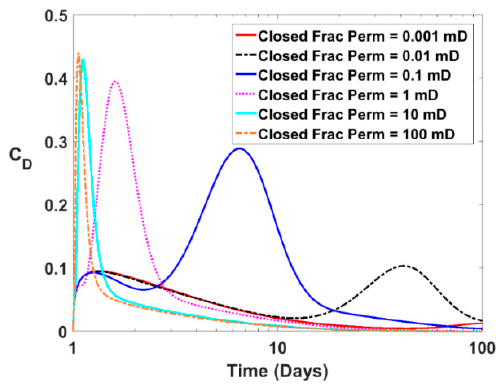
Figure 22. Impact of residual fracture permeability of IU fractures on tracer response curves.